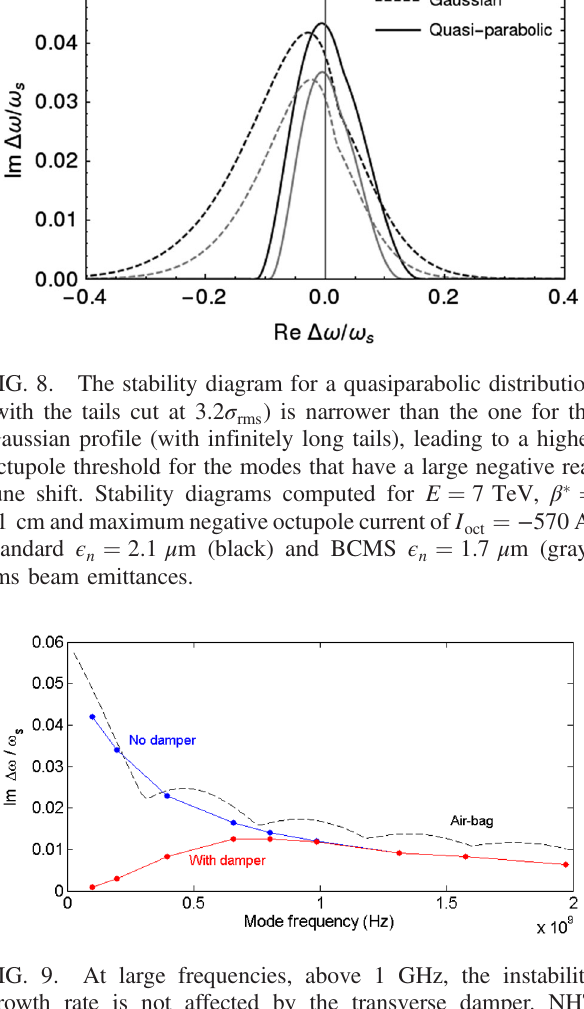
FIG. 9. At large frequencies, above 1 GHz, the instability growth rate is not affected by the transverse damper. NHT simulation for a Gaussian beam with a 50 turn (blue line) and without (red) the damper and an analytical solution for an airbag beam in the weak head-tail limit (dashed black line).